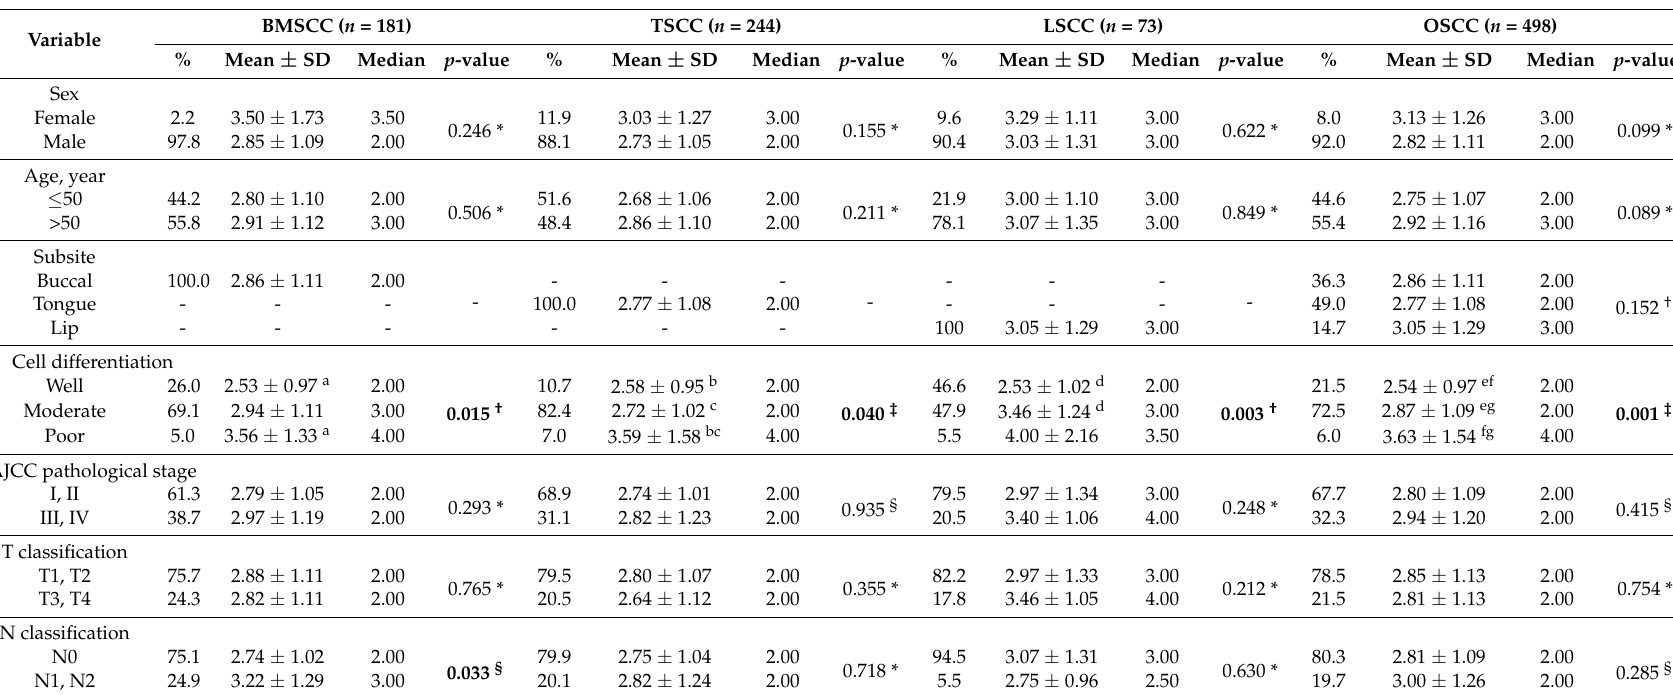
Table 3. Expression of SQSTM1 and clinicopathologic outcomes in patients with OSCC and three primary